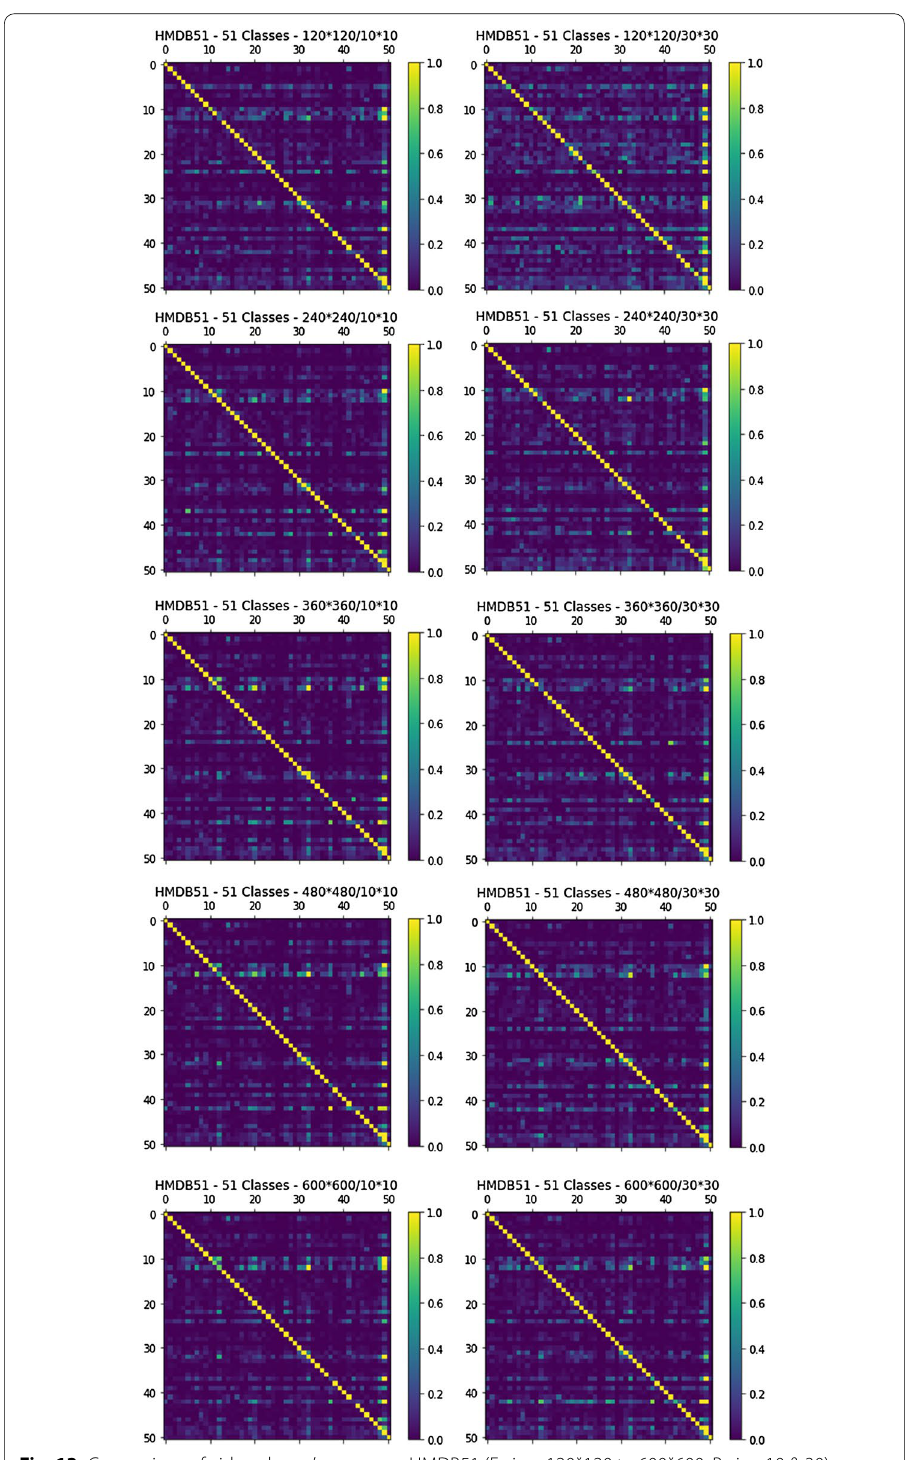
Fig. 13 Comparison of video classes’ accuracy—HMDB51 (F‑size : 120*120 to 600*600, B‑size: 10 &